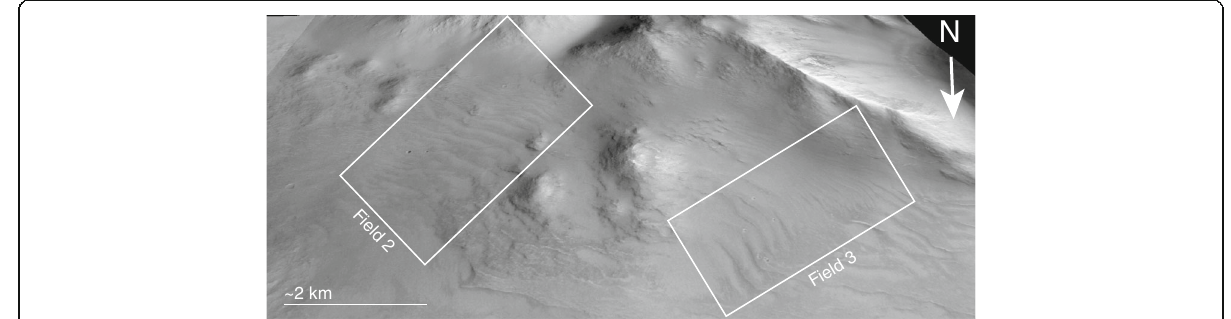
Fig. 11 A close-up of potential contemporary cyclic steps (field 2 and field 3) on the Aeolis Mensae Delta